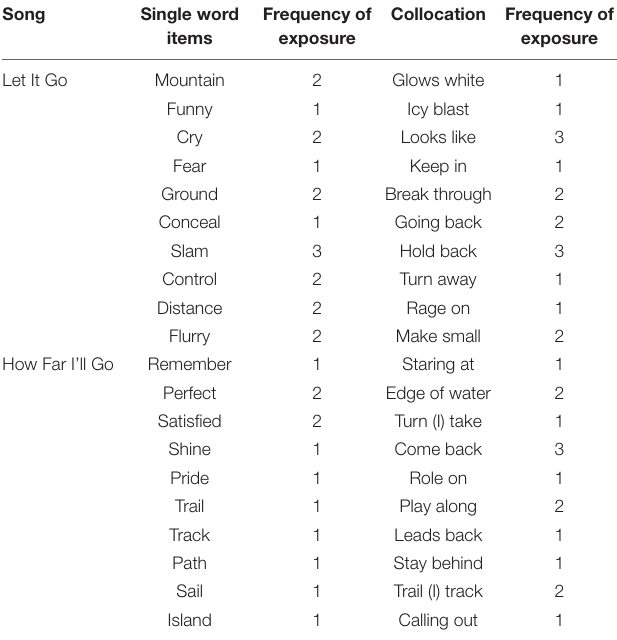
TABLE 2 | The target items for the two songs. Song